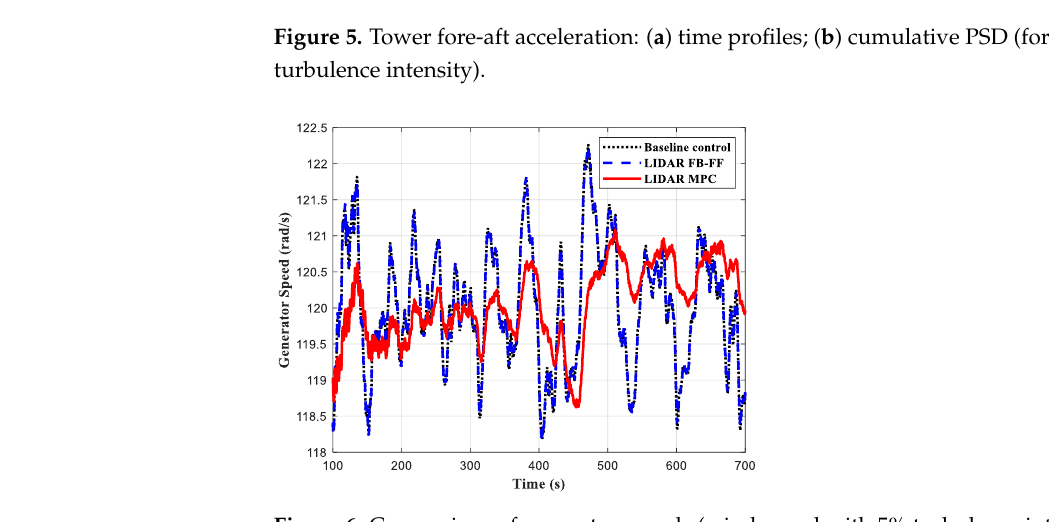
Figure 6. Comparison of generator speeds (wind speed with 5% turbulence intensity).